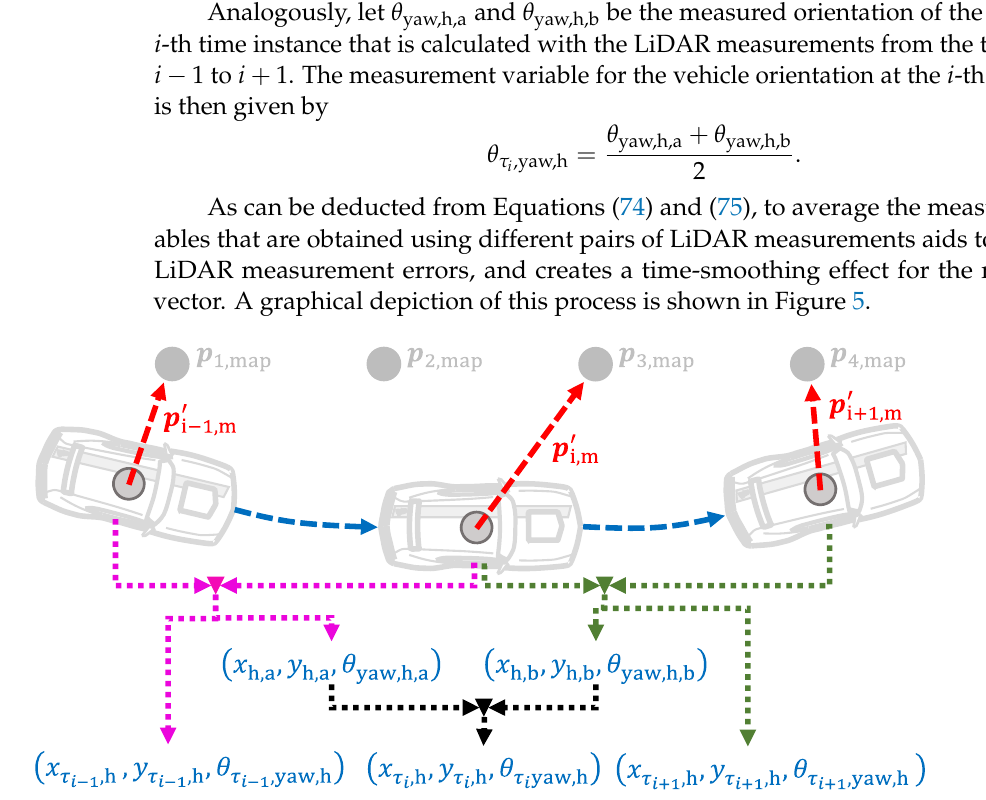
Figure 5. Shown is a graphical depiction of the generation of the measurement variables for the vehicle pose, as computed from LiDAR